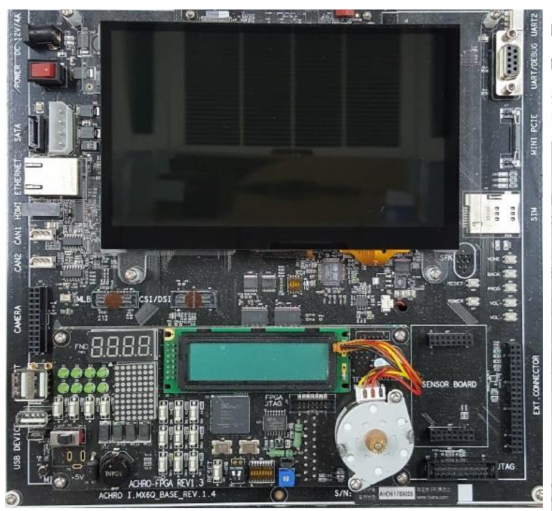
Figure 2. Freescale I.MX6Q Cortex-A9 board.